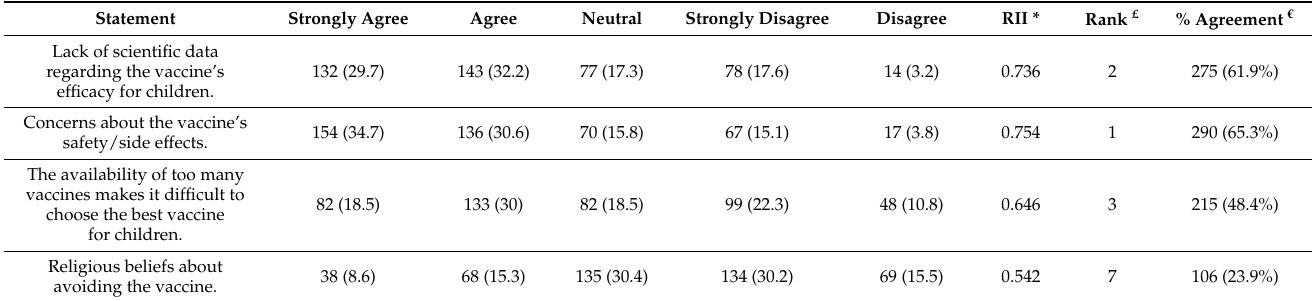
Table 3. Potential barriers to uptake of the childhood COVID-19